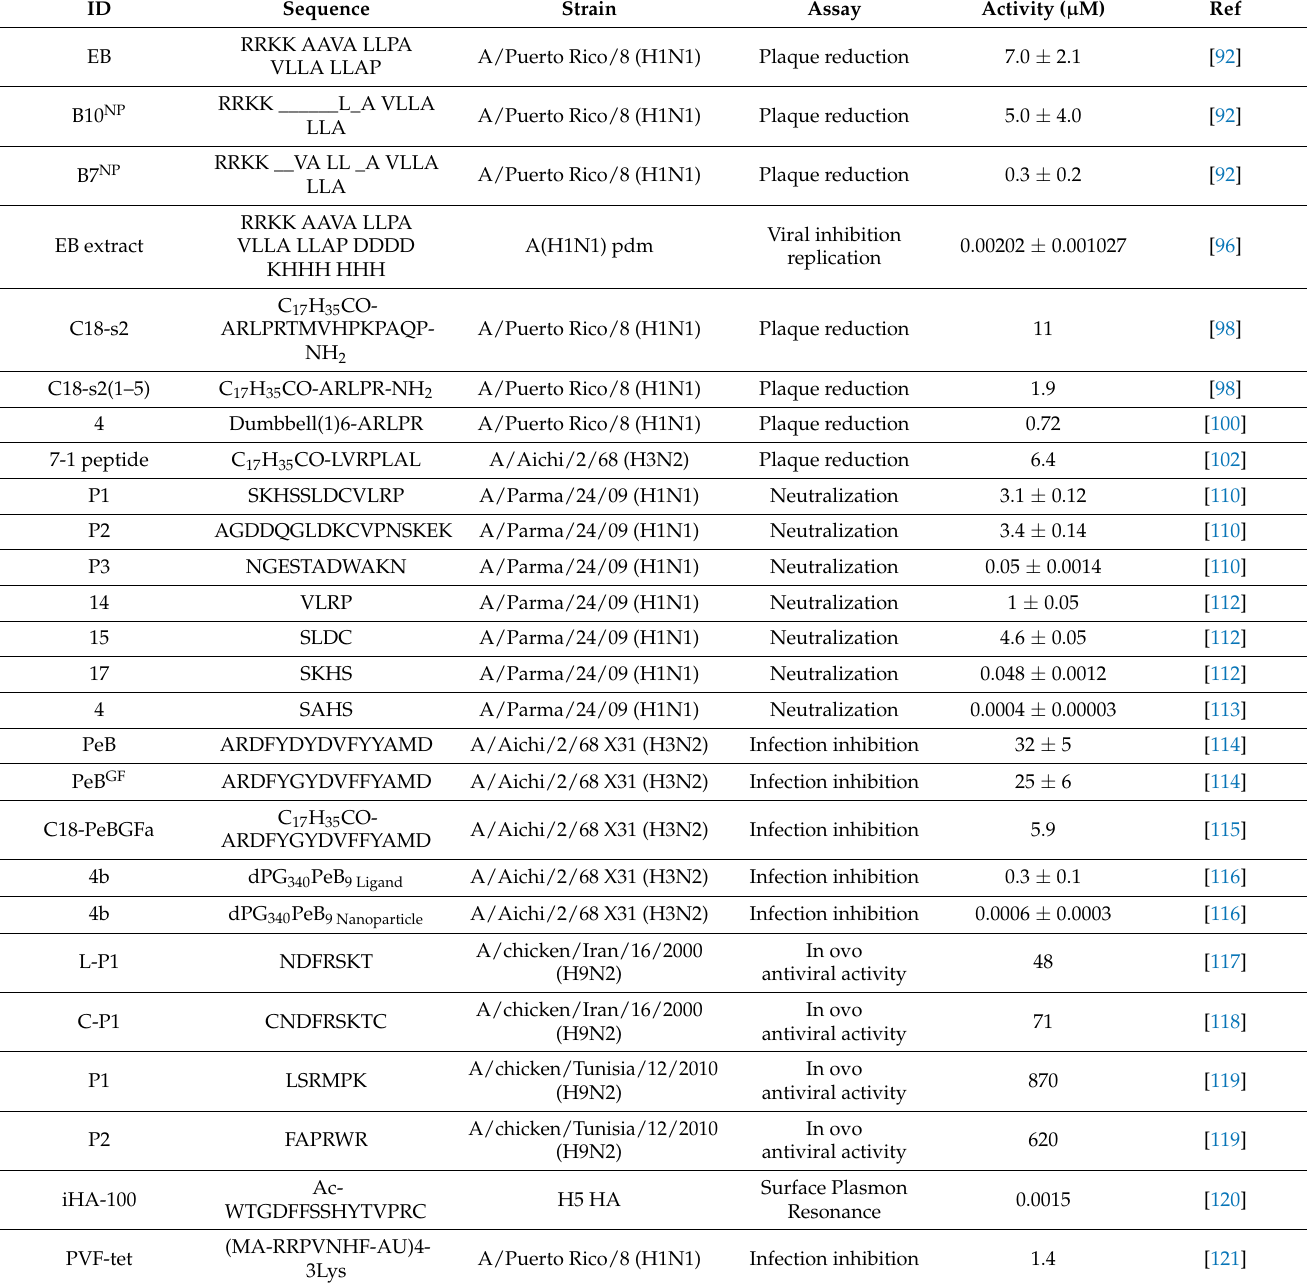
Table 2. Most representative peptides interfering with the sialic acid binding to